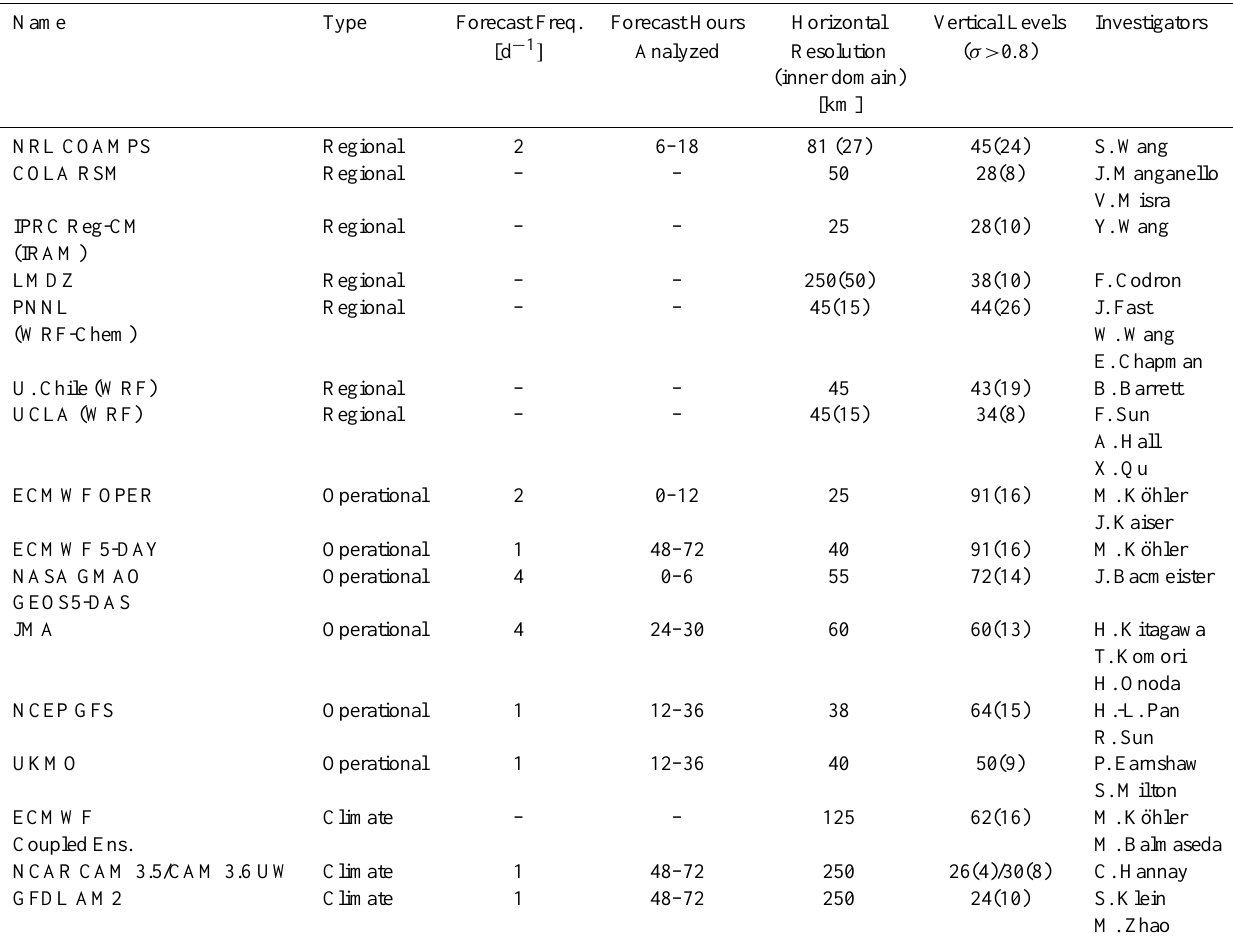
Table 1. Participating